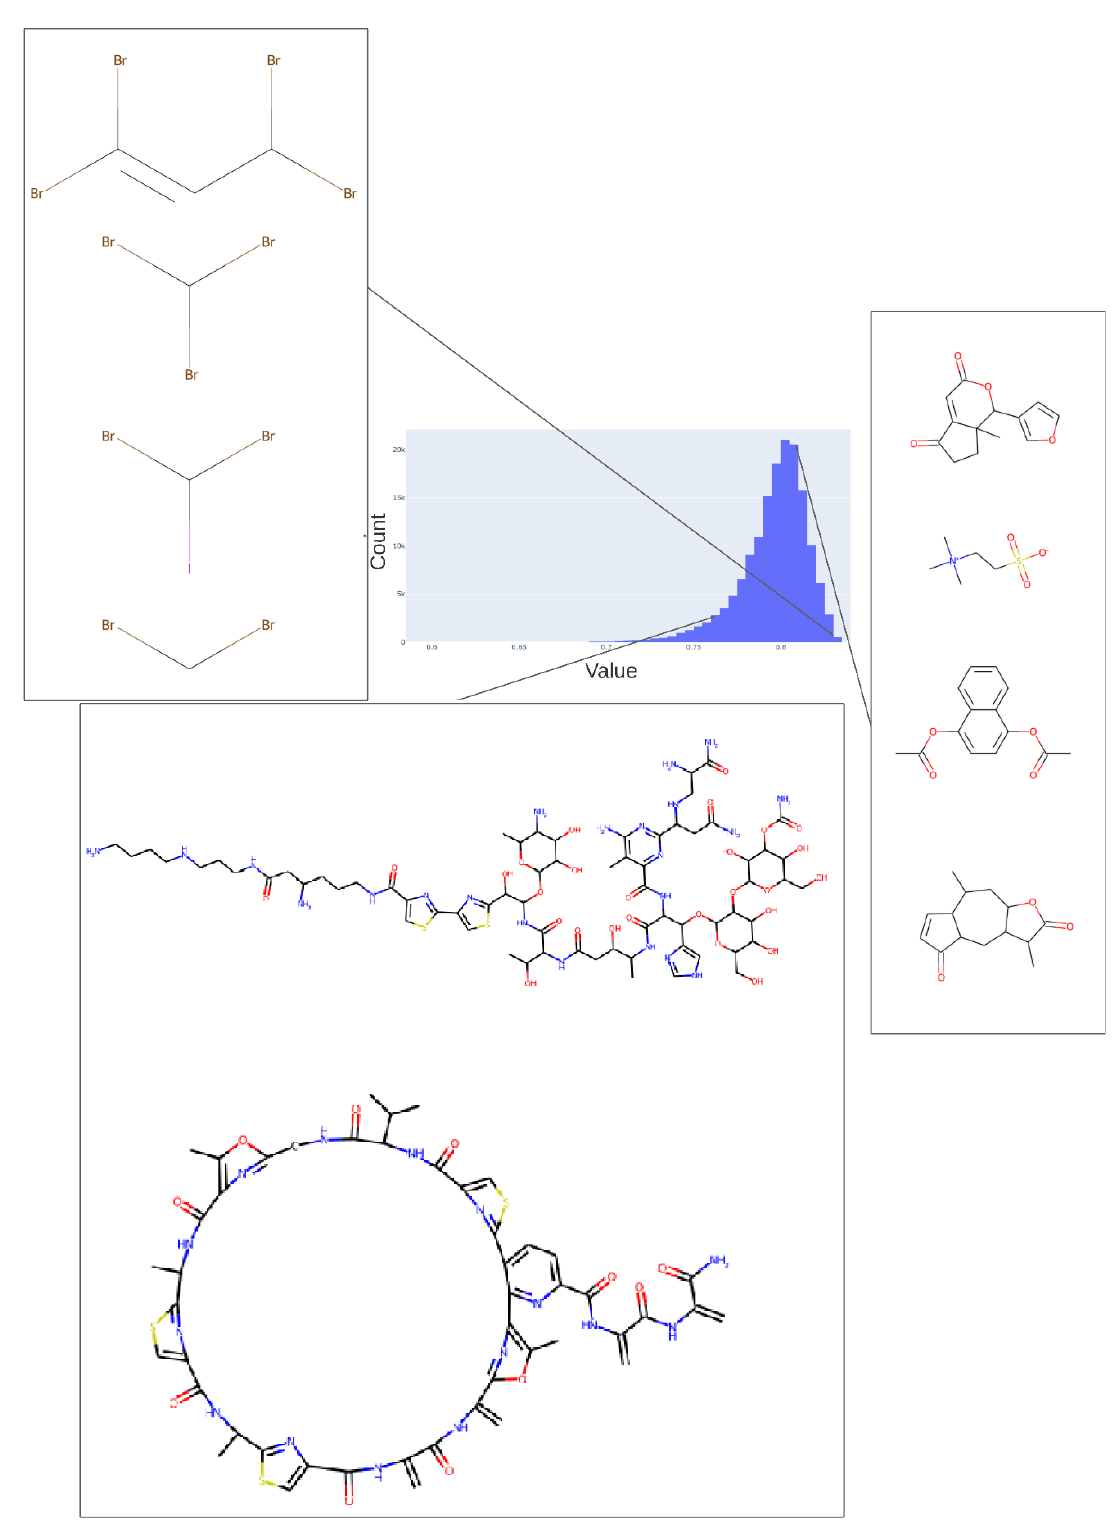
Figure 6. Values adopted in dimension 182 of the trained 256-D transformer, showing the values of various halide-containing (~0.835) and other molecules. As in Figure 5, we indicate the bins in the histogram of values (0.76, 0.81, 0.83) in this dimension from which the representative molecules shown were taken.